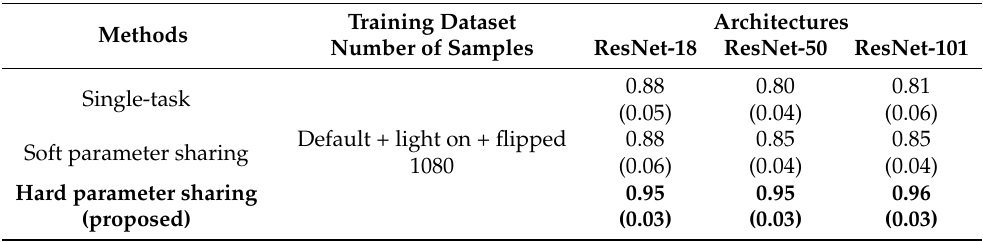
Table 9. Comparisons of results using the different methods of multi-task learning with three ResNet architectures, in terms of exact match ratio. The best values for each architecture are in